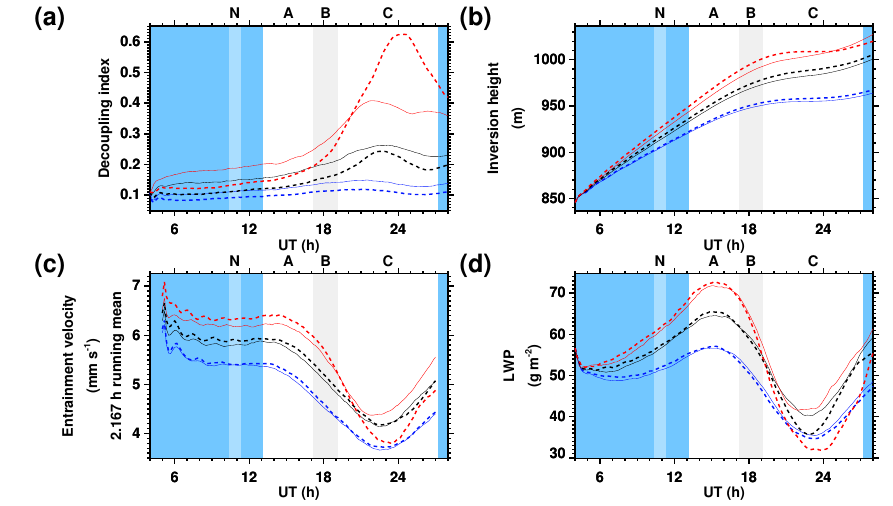
− + 0 (blue), L (black), L (red), solid curves, and from